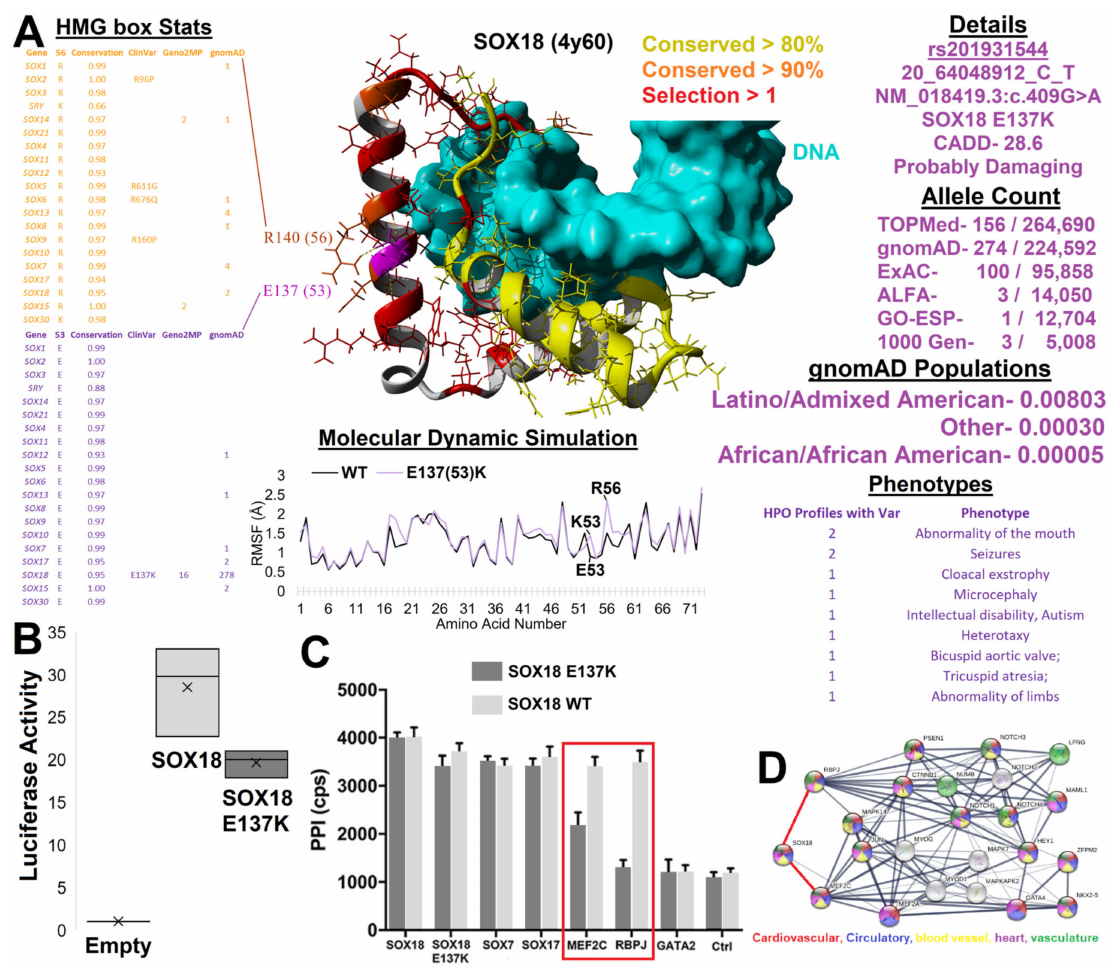
Figure 5. SOX18 E137K. ( A ) Integrated data and structure of SOX18 E137K. In the middle is the SOX18 structure (PDB file 4y60) bound to DNA (cyan). Amino acids are colored based on con- servation and selection as labeled. To the left of the structure is the annotation of the HMG box compiled data for R56 (yellow) and E53 (magenta) amino acids. Below are 20 nanoseconds of mds for wild type (WT, black) or E137K (magenta), showing the root-mean-squared fluctuation for each amino acid. To the right are various data insights for E137K, including the multiple an- notations, allele counts, and Geno2MP phenotypes. ( B ) Transcriptional activity of empty plasmid (empty normalized to 1), with SOX18 (gray) or SOX18 E137K (black) overexpressed in combination with an SOX response element driving luciferase production in HeLa cells. ( C ) ALPHAScreen as- say to assess pairwise interactions between SOX18 WT or the SOX18 E137K variant with known protein partners. GATA2 is a known nonbinding control that provides a baseline ALPHAScreen signal similar to the control condition with buffer only (Ctrl). Error bars represent the standard error of the mean of three independent experiments. ( D ) STRING analysis of SOX18, MEF2C, and RBPJ with the first and second shells of the network with no more than ten interactions added in. Colors represent GO enrichments as follows: red—cardiovascular system development (GO:0072358; FDR— 9.18 × 10 − 15 ); blue—circulatory system development (GO:0072359; FDR = 9.18 × 10 − 15 ); yellow—blood vessel development (GO:0001568; FDR = 2.67 × 10 − 13 ); magenta—heart development (GO:0007507; FDR = 2.67 × 10 − 13 ); green—vascular development (GO:0001944; FDR = 3.55 × 10 − 13 ). The raw TIF file can be found at https://doi.org/10.6084/m9.figshare.21830421.v1 (accessed on 18 December